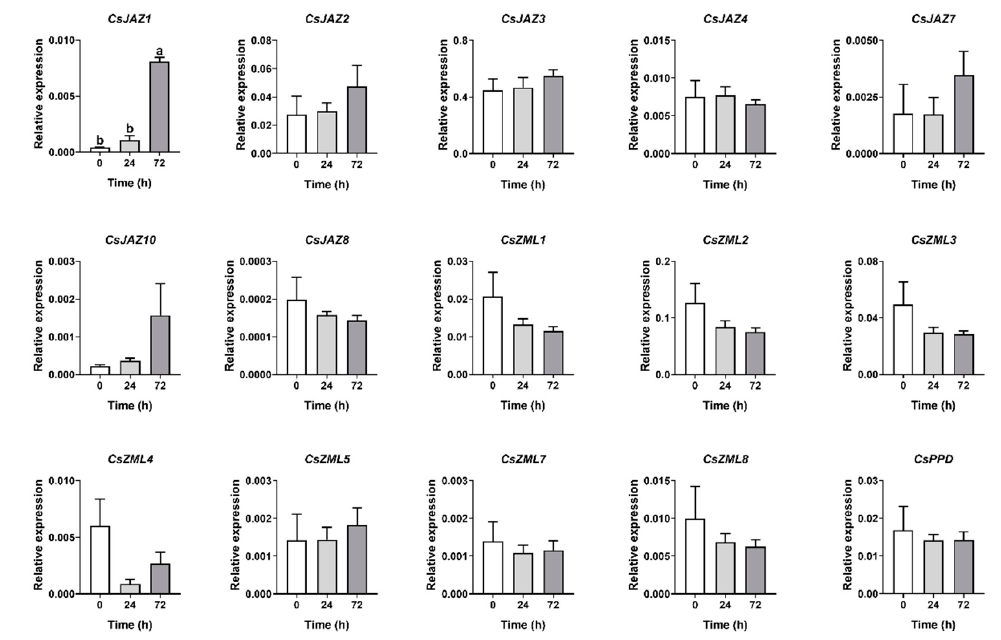
Figure 8. Expression profile of CsTIFY genes elicited by C. camelliae infection. Data are shown by the mean + SE, di ff erent letters indicate significant di ff erence among di ff erent organs (Turkey’s honest mean + SE, different letters indicate significant difference among different organs (Turkey’s honest significant di ff erence (HSD) post-hoc test, p < 0.05, n = significant difference (HSD) post-hoc test, p < 0.05, n = 6).